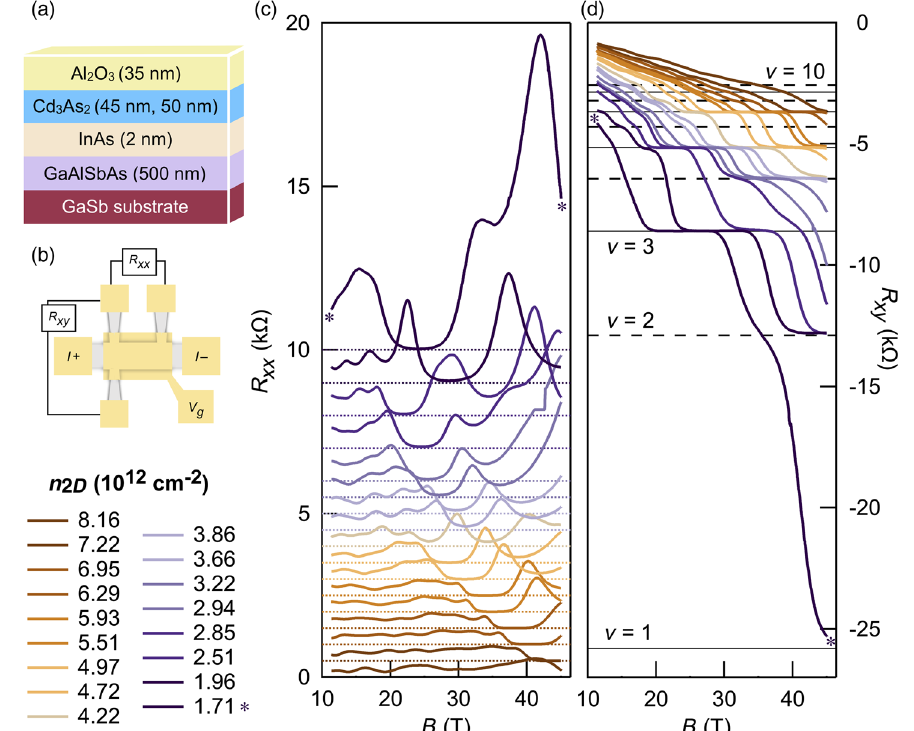
FIG. 1. (a) Schematic of heterostructure (not to scale). (b) Schematic of the gated Hall bar device (not to scale). The gate metal is separated from the mesa by the Al 2 O 3 layer, and the other contacts are in contact with the Cd 3 As 2 layer. Note that the contacts for current injection and voltage measurement connect both Cd 3 As 2 layer surfaces. (c) Longitudinal magnetoresistance ( R ( R ) for the device fabricated on a 45-nm-thick Cd 3 As 2 layer. Different traces correspond to different gate biases or, equivalently, carrier xy densities. The 2D carrier densities are calculated from the 11.5 to 11.75 T Hall resistance and correspond to gate bias from about þ 3 to − 4 V. In (c), traces are offset for legibility. For each trace, zero is indicated by a dotted horizontal line. In (d), odd (even) filling factors are indicated by solid (dashed)